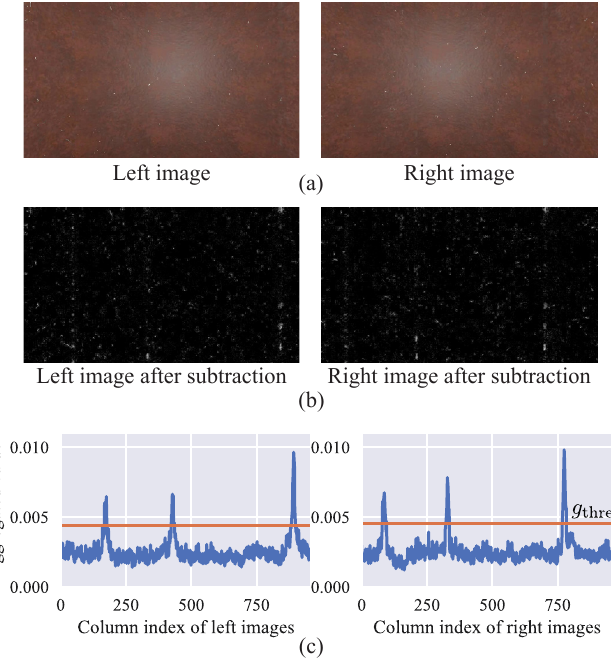
Figure 6. Intermediate representation of proposed method. ( a ) Input stereo image with radiation noise. Please check the supplemental video. ( b ) Images obtained after background subtraction, F . ( c ) Vertically aggregated values of F